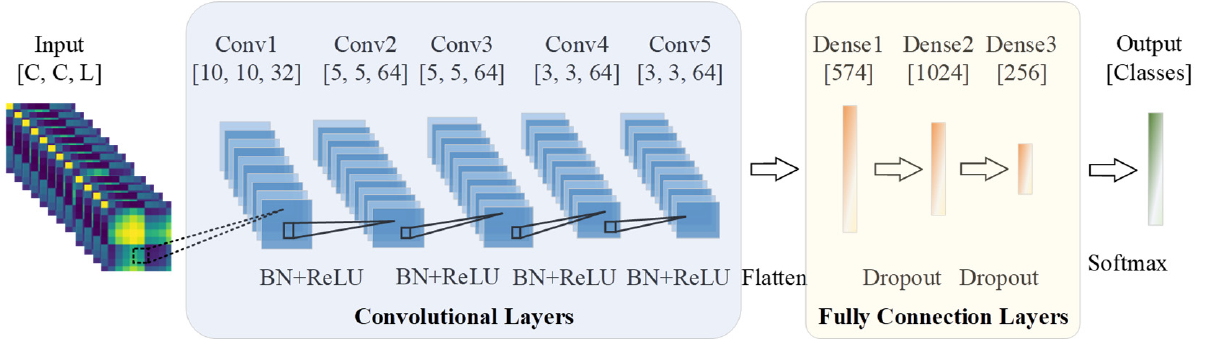
Figure 5. The architecture of the proposed five-layer convolutional neural network consists of an input layer, five convolutional layers, and three fully connected layers. The network’s input is a clip of a sequence of sEMG images with size C × C × L , where C is the number of sEMG sensor channels, and L is the duration of the sliding time window. Outputs of network are class labels of hand gestures. The dotted line between the input layer and the first convolutional layer denotes the kernel size. Therefore, the stride applied to the input layer should differ according to the size of an input image.